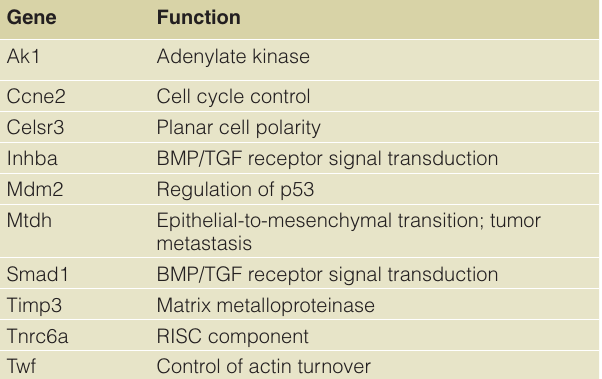
Table 1. Candidate miR-30 target